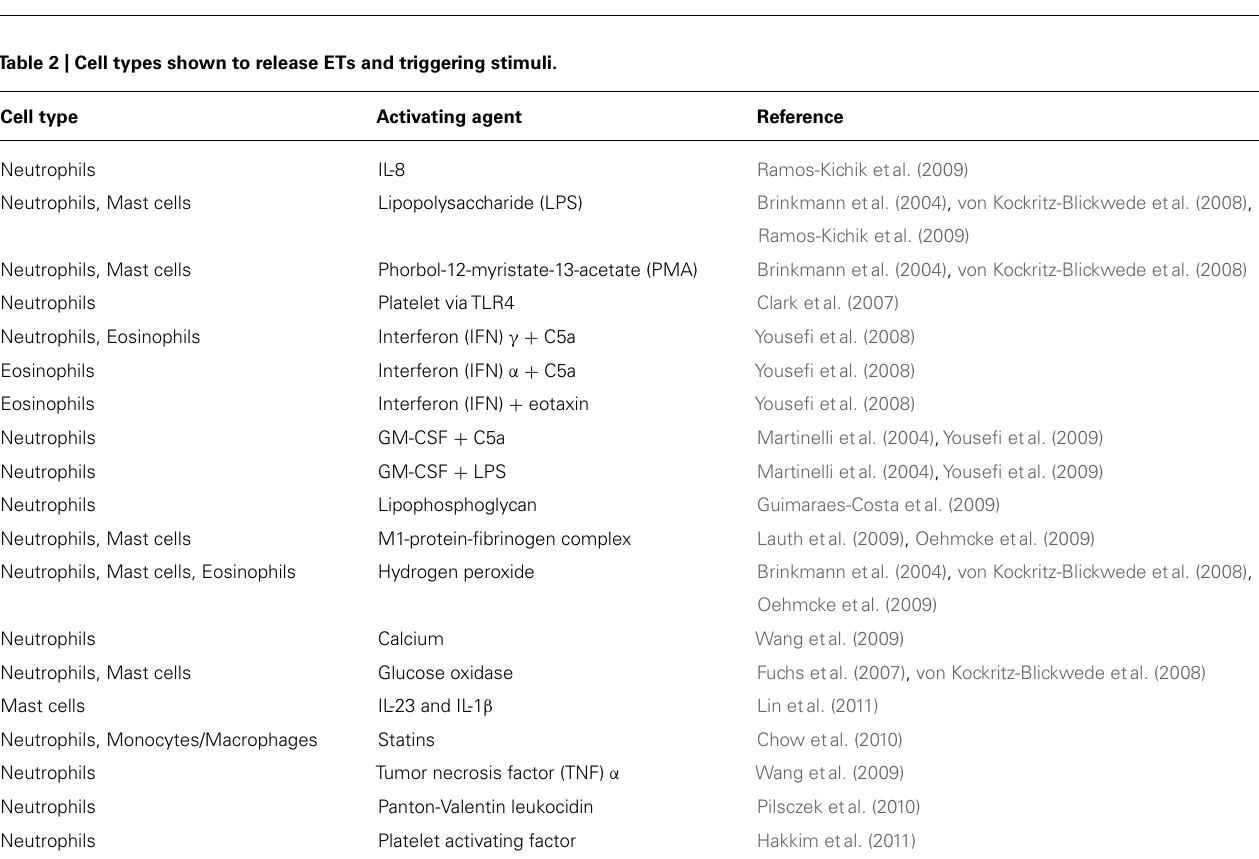
Table 2 | Cell types shown to release ETs and triggering